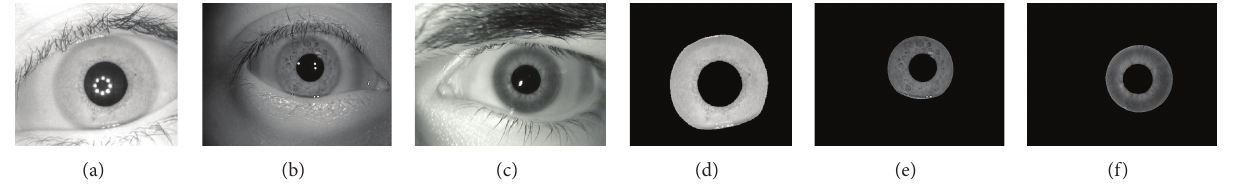
Figure 1: Examples of segmented iris images. (a), (b), and (c) are original iris images, (a) from CASIA-V3 Interval database (S1002L04.jpg), (b) from CASIA-V3 Lamp database (S2005R02.jpg), and (c) from MMU-V1 database (yannl5.bmp, left) database, respectively. (c), (d), and (e) are segmented iris images which correspond to (a), (b), and